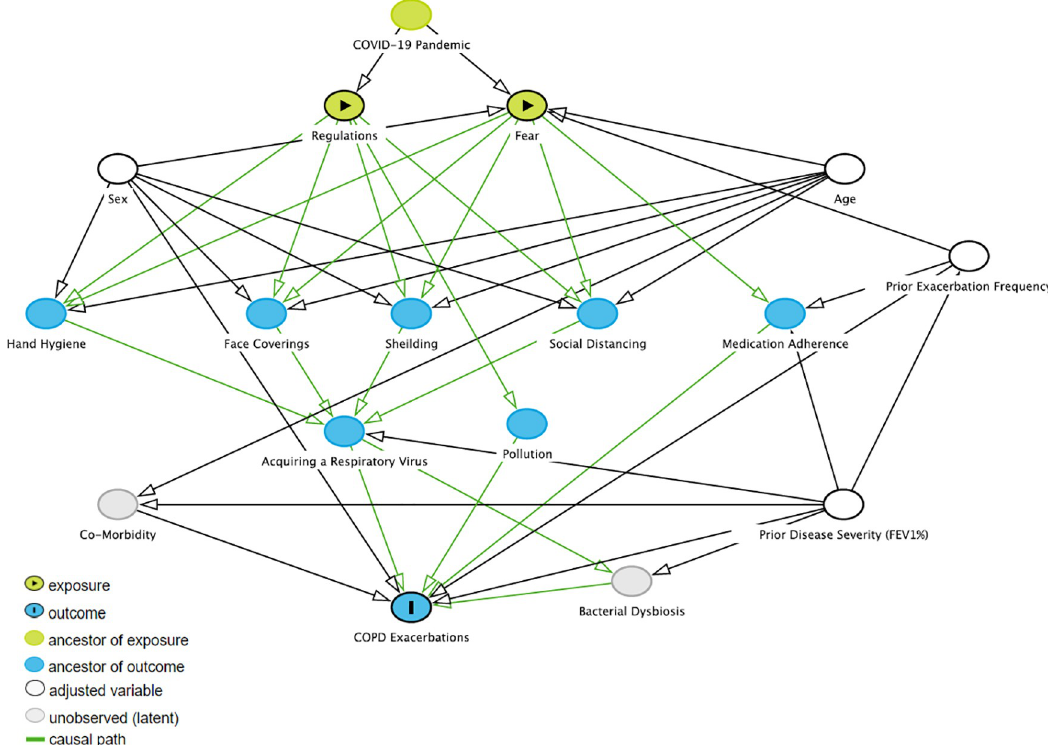
Fig 4. Directed acyclic graph describing relationships between the COVID-19 pandemic and a reduction in COPD exacerbations. We first considered factors known to be associated with COPD exacerbation risk (the outcome). We then considered respiratory virus infection control interventions developed during the pandemic (‘regulations’), and other variables associated with the pandemic that might associate with exacerbation risk: fear of coronavirus. We therefore considered regulation and fear to be the exposures, both arising from the COVID-19 pandemic. The DAG suggests that age, sex, prior exacerbation frequency and prior disease severity (FEV1% predicted) are potential confounders.